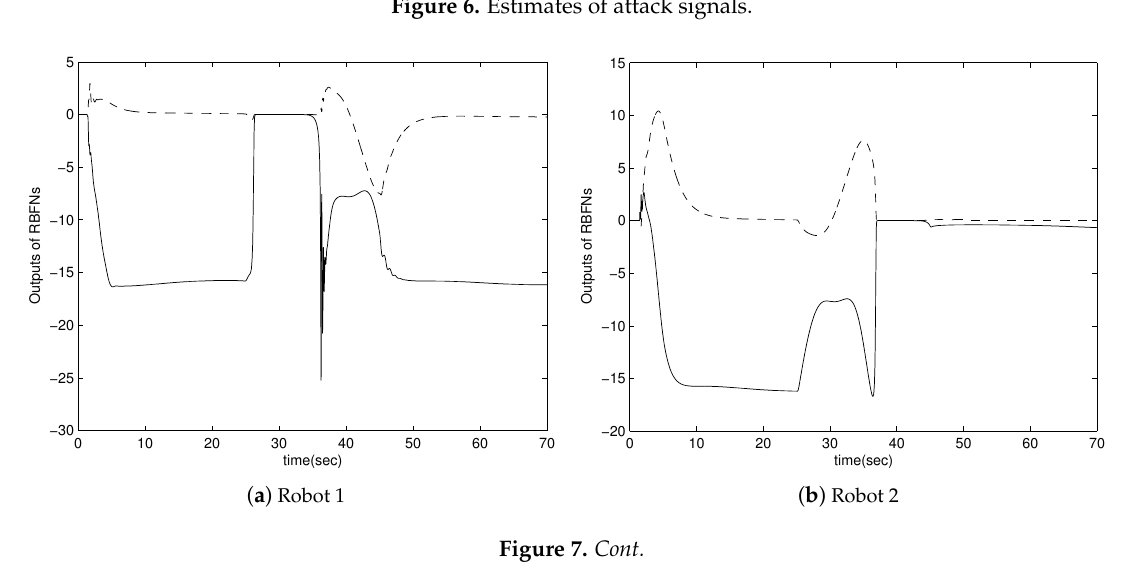
Figure 6. Estimates of attack signals.